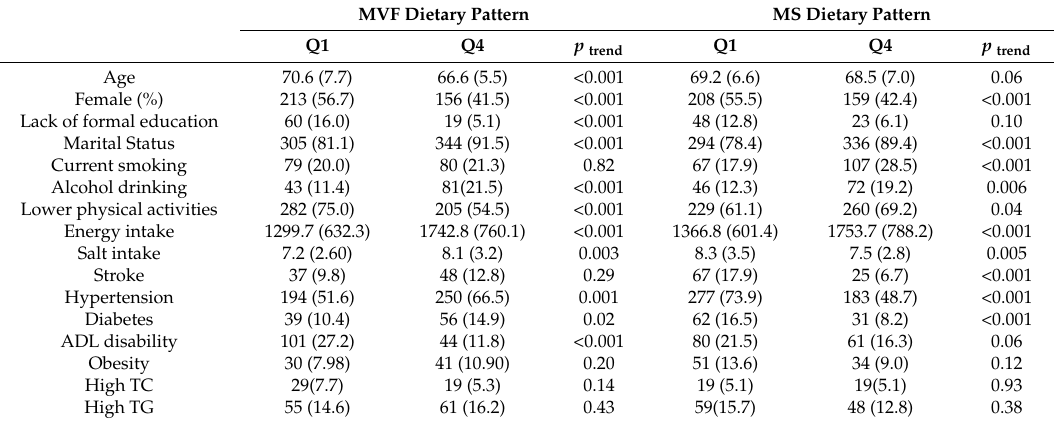
Table 3. Characteristics of study participants by quartile categories of each dietary pattern score a